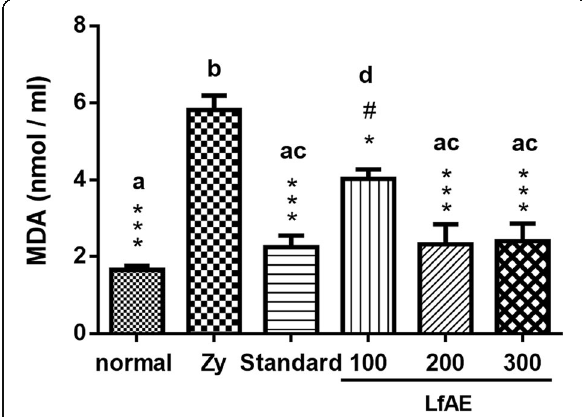
Fig. 5 Effect of LfAE (100, 200 and 300 mg/kg) on the levels of malondialdehyde in the zymosan-induced arthritis model. Data are expressed as mean ± SD (One-way ANOVA, Tukey-Kramer test, n = 6 per group). Letters ( a , b , c , d ) refer to the result of Tukey-Kramer post hoc test. Groups that do not share a letter have a mean difference that is statistically significant. *( p < 0.05), ***( p < 0.001) vs zymosan control group (Zy); #( p < 0.05) vs normal control group